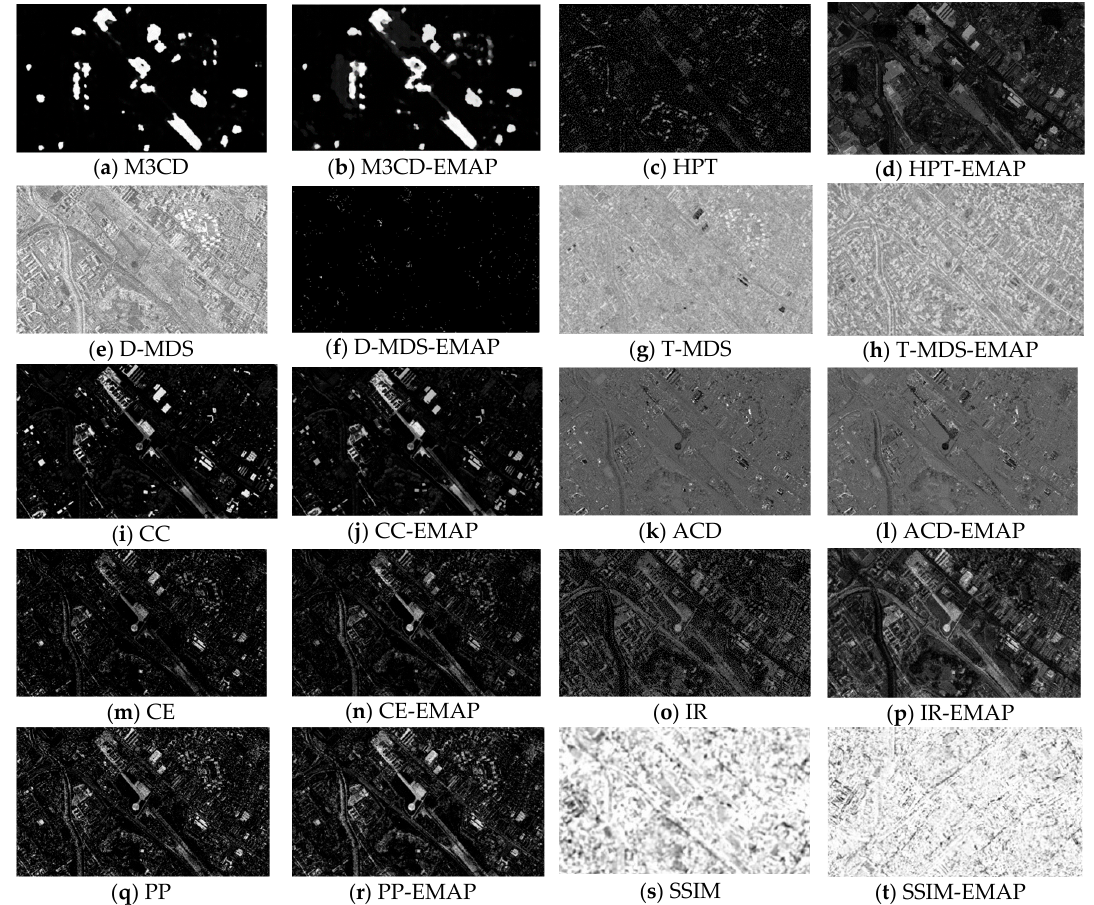
Table 5. AUC values and differences between single band and EMAP cases for dataset-4. Bold numbers indicate the best performing method in each column.